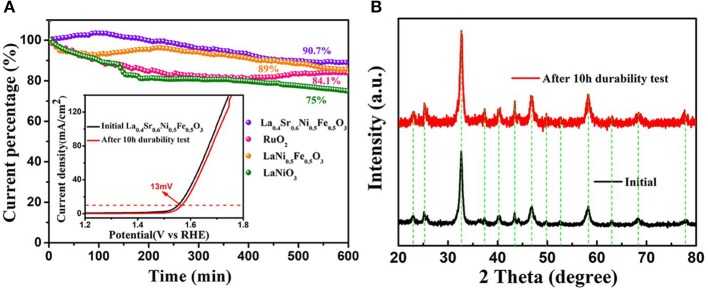
(A) Chronoamperometric response of La0.4Sr0.6Ni05Fe0.5O3, commercial RuO2, LaNi0.5Fe0.5O3 and LaNiO3, where inset shows the LSV curves of La0.4Sr0.6Ni05Fe0.5O3 before and after 10 h durability test. (B) The XRD patterns of La0.4Sr0.6Ni0.5Fe0.5O3 before and after 10 h durability test.